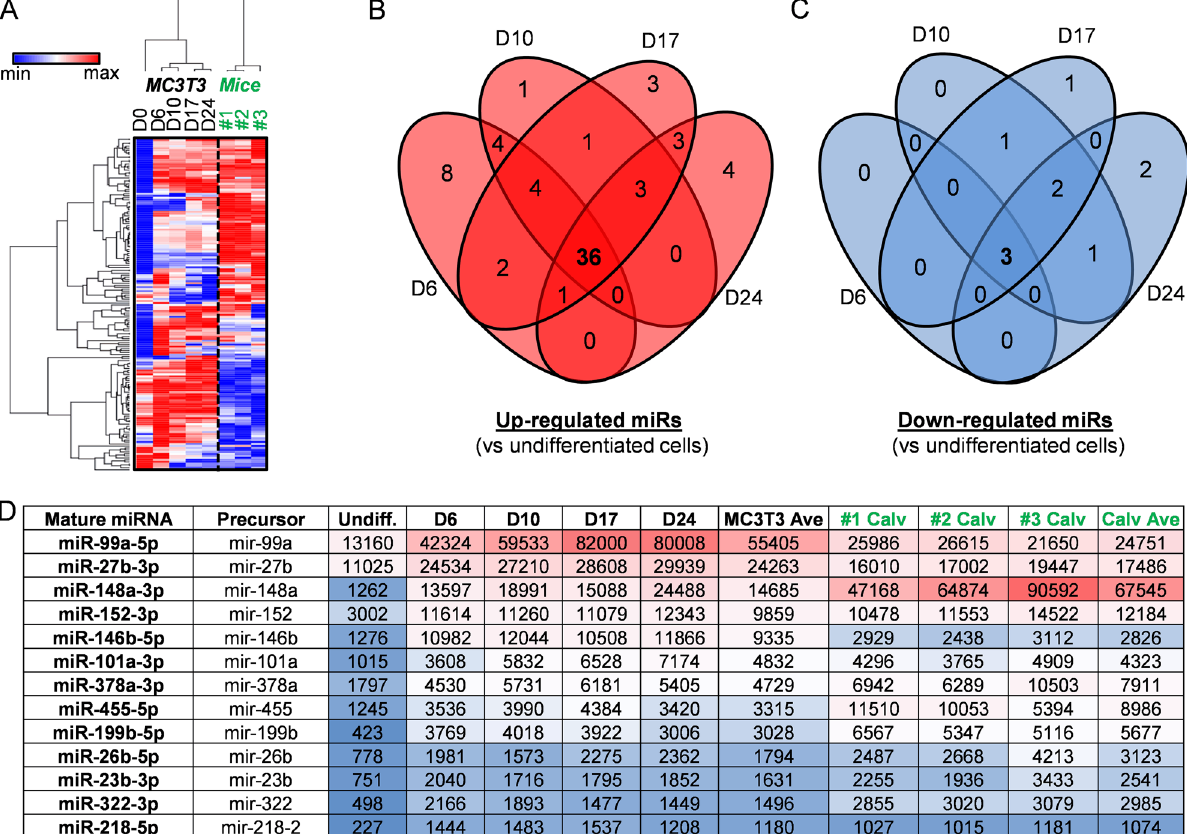
Figure 1. miRNA expression patterns in differentiating MC3T3 cells and primary mouse calvaria. miRNA-Seq analysis was performed on RNA derived from MC3T3 cells undergoing osteogenic differentiation (days 0, 6, 10, 17, and 24) and primary female mouse calvaria (animal identification #1, #2, and #3). Hierarchical clustering of miRNAs robustly expressed (CPM > 100 across five samples) in differentiating MC3T3 cells (n = 168) ( A ). The distribution of miRNAs in primary mouse calvaria (n = 3) are also included for in vivo relevance. Venn diagram analysis of robustly expressed miRNAs (n = 168) that are up-regulated ( B ) and down-regulated ( C ) across various differentiation time points (days 6, 10, 17, and 24) relative to undifferentiated cells (day 0) in MC3T3 cells (fold change (FC) > 2). Table summarizing commonly up-regulated miRNAs (see Panel B) that are highly expressed in MC3T3 cells and primary mouse calvaria [CPM > 1000 on average in MC3T3 cells (n = 5) and primary mouse calvaria (n = 3)] ( D